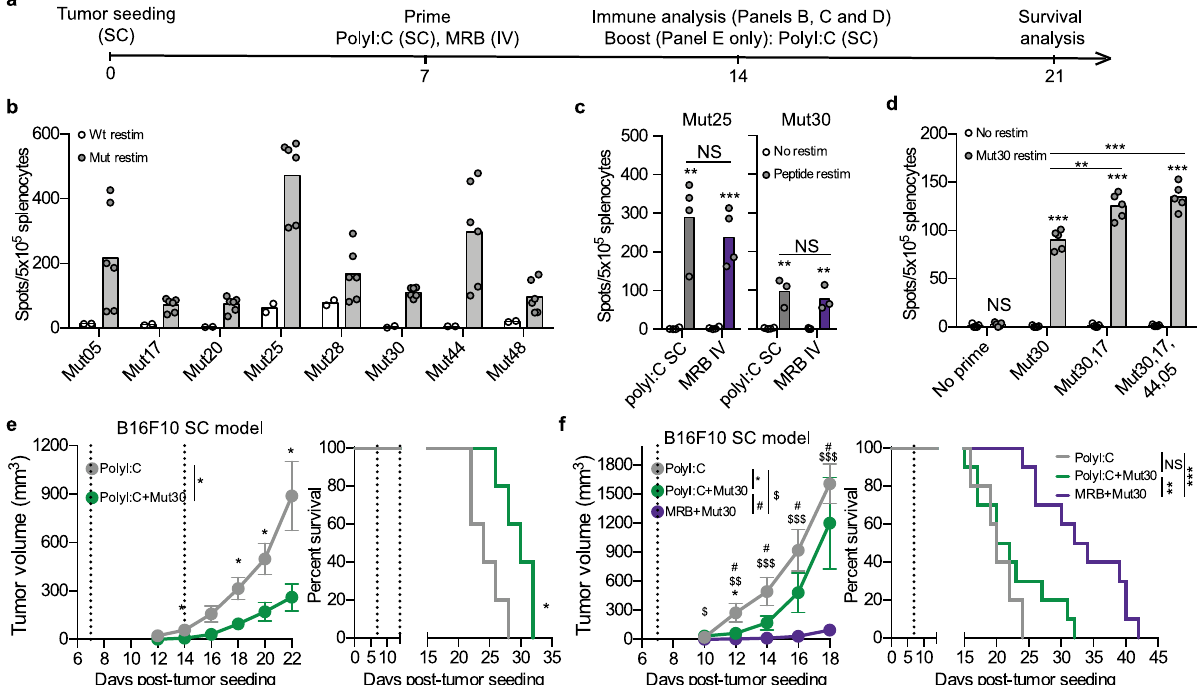
Fig. 5 OVs can be used as adjuvants for vaccination against cancer neo-epitopes. a Treatment schedule used in this study. IFN γ ELISPOT analyses of splenocytes from mice immunized with; b polyI:C co-administered with different B16F10Muts (IM) and re-stimulated ex-vivo with the same or the corresponding non-mutated peptides ( n = 2 (WT restim) and 6 (Mut restim)); c polyI:C or MRB co-administered with different B16F10Muts and re- stimulated ex-vivo with the same peptides or (from left to right; n = 4, 4, 3 and 3); d polyI:C co-administered with 1, 2 or 4 different Muts (100 μ g each) and re-stimulated ex-vivo with Mut30 ( n = 5). Unless indicated otherwise, the statistical analyses refer to the comparison between the corresponding “ No restim ” and “ restim ” conditions. NS: p > 0.05, *: p < 0.05, **: p < 0.01, ***: p < 0.001 (unpaired two-tailed t -test). Tumor growth (left panels) and Kaplan – Meier survival analyses (right panels) of B16F10 SC tumor-bearing mice immunized with; e polyI:C ± Mut30 on days 7 and 14 or ( n = 5), Data are presented as mean values ± SEM.; f polyI:C or MRB + Mut30 on day 7 ( n = 10). Data are presented as mean values ± SEM. Tumor growth analyses: NS: p > 0.05, *: p < 0.05, ***: p < 0.001 (unpaired multiple two-tailed t -tests) and survival analyses: NS: p > 0.05, *: p < 0.05, **: p < 0.01, ***: p < 0.001 (Mantel – Cox test, two-sided). Source data are provided as a Source Data fi le. Exact p values can be found in the Source